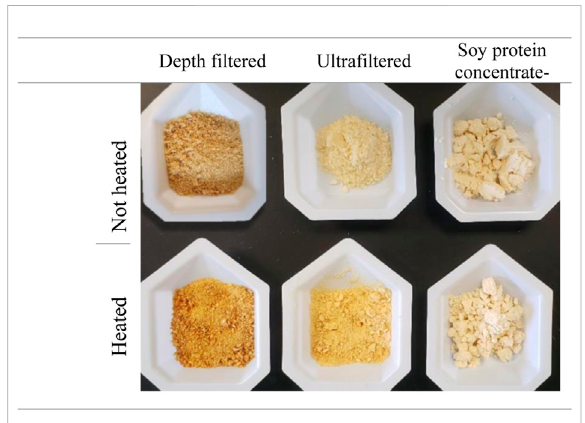
FIGURE 6 Effect of heating (95 ° C for 10 min) on depth- fi ltered (DpF- hydrolysates) and ultra- fi ltered (UF-hydrolysates) hydrolysates. – Non-heated samples are shown in the top row and heated ones on the